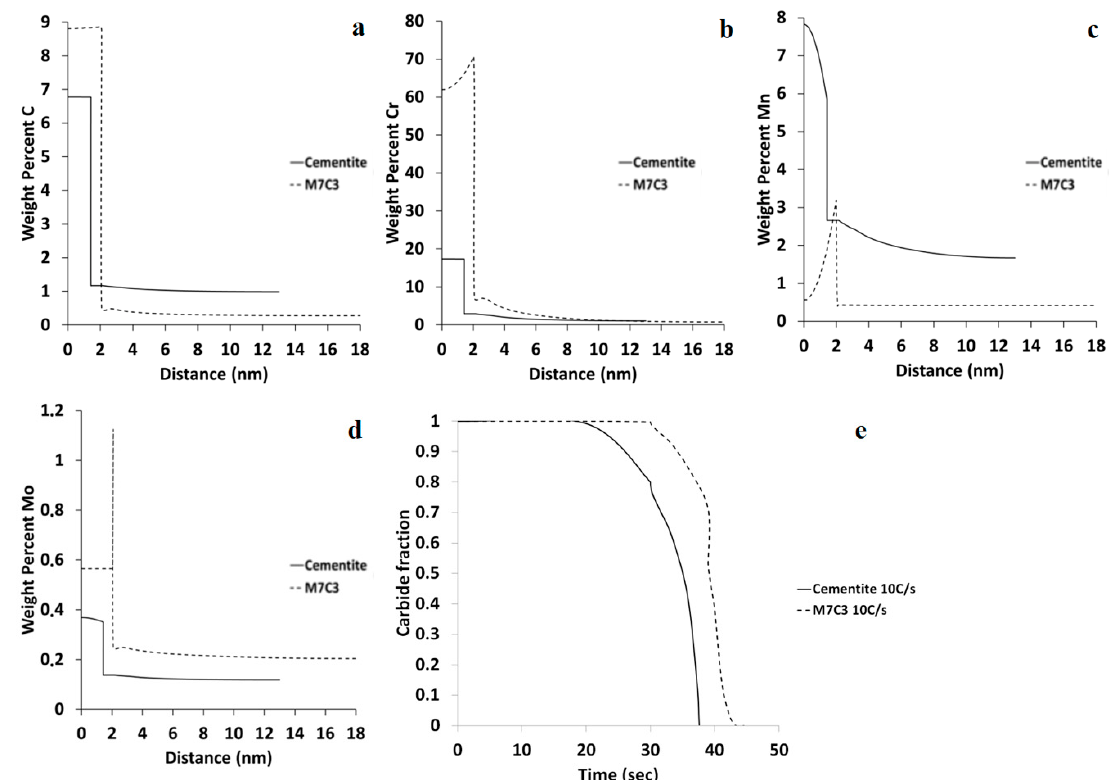
Figure 9. Composition profiles during carbide dissolution in austenite at T peak for the UFH sample, spherical cell, size 5 nm ( a ) C, ( b ) Cr, ( c ) Mn, ( d ) Mo content, respectively. ( e ) Diagram of carbide fraction change in conjunction with time during dissolution for heating rate 10 °C/s.